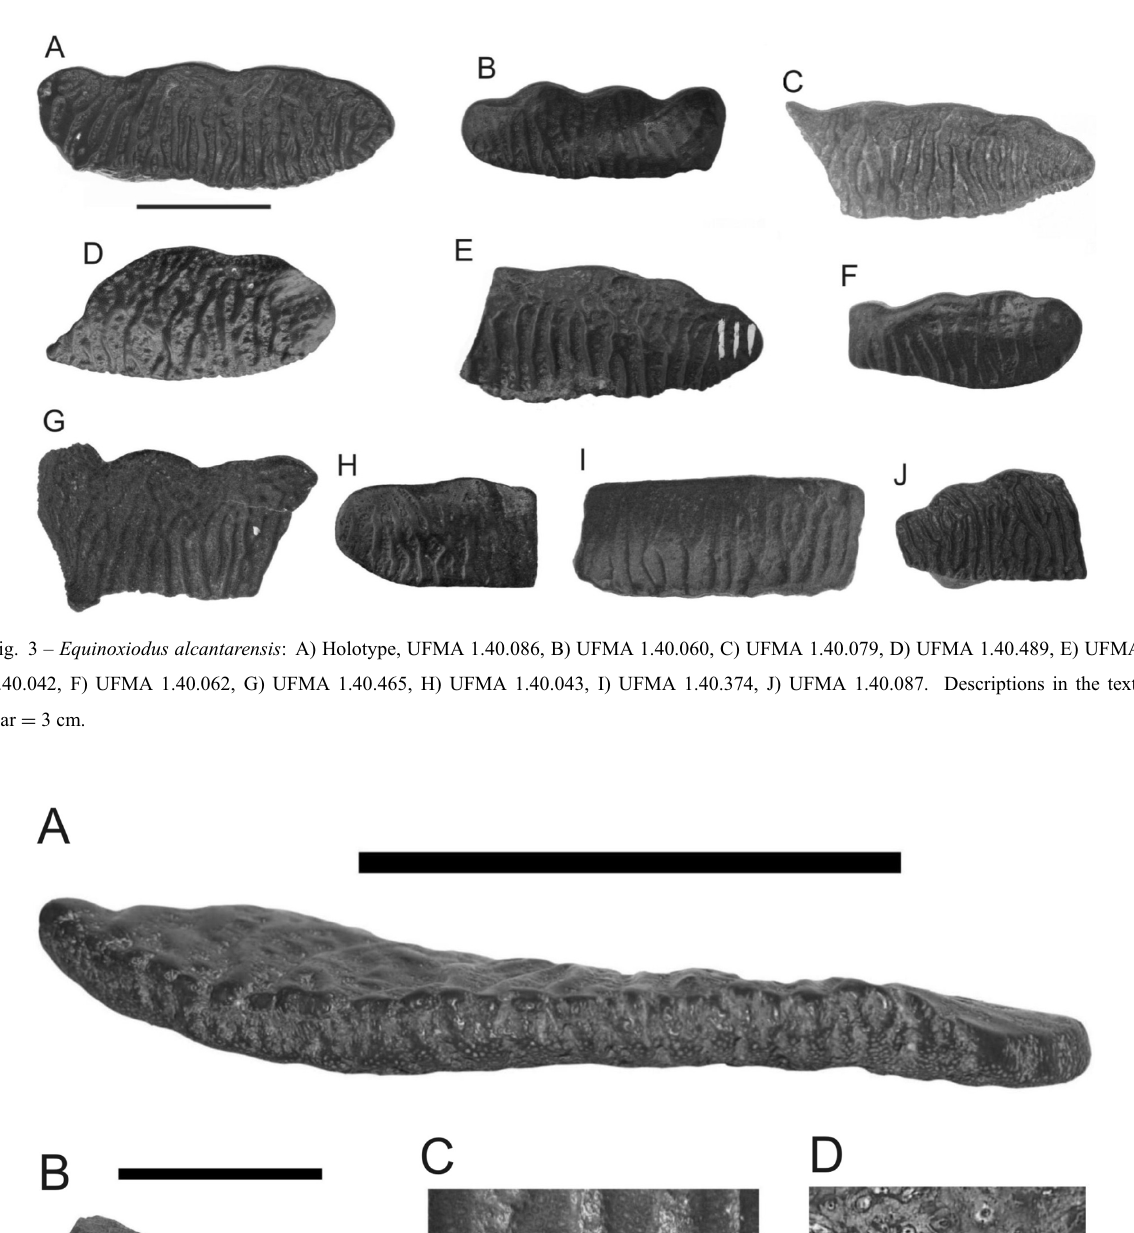
Fig. 4 – Equinoxiodus alcantarensis : A) UFMA 1.40.489 in lingual view showing the undulating occlusal surface (bar = 3 cm); B) mesial face of UFMA 1.40.465 (bar = 2 cm); C) Detail of ornamentation on the tooth plate UFMA 1.40.086 (bar = 5 mm); D) Predominance of petrodentine on the fine lines (arrow) of the occlusal pitted surface (50 ×